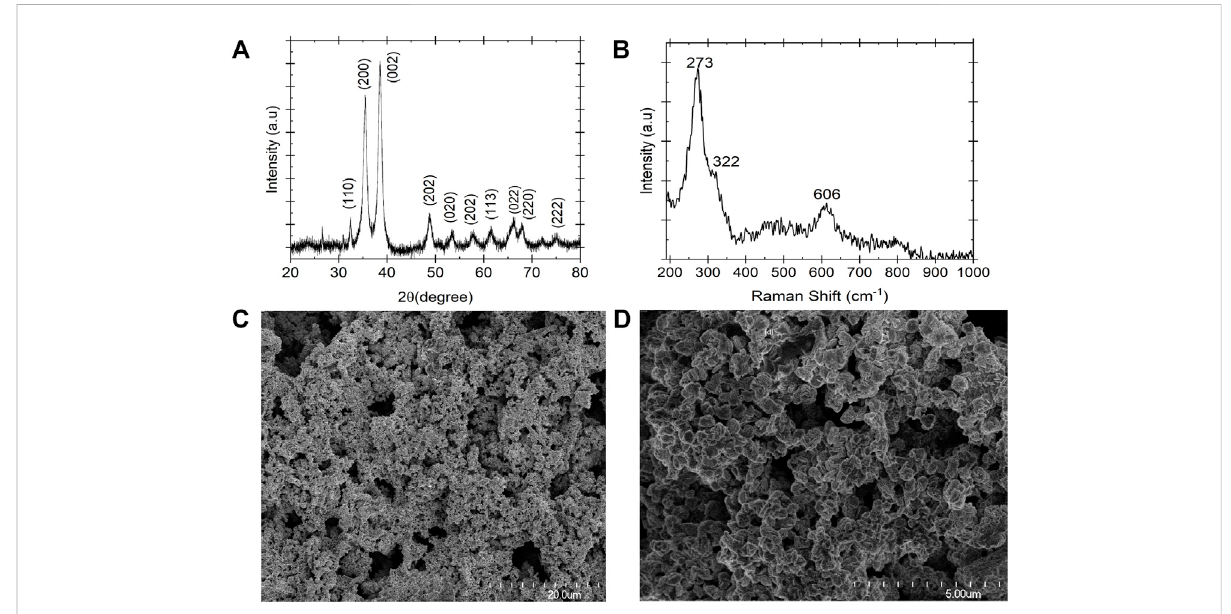
FIGURE 4 Characterization of copper oxide fi lm formed on the surface of the copper substrate after electrochemical conversion of the solid samples in 0.2 M NaOH at 35 ° C. (A) XRD pattern (B) Raman Spectra and (C,D) FE-SEM image. The XRD and Raman spectra con fi rmed the copper oxide fi lm formation, and the FE-SEM image shows the spherical arrangement of the fi